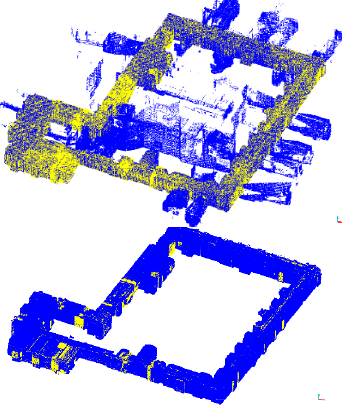
Figure 3. Pre-processing of two datasets, MMS (yellow) and SLS acquisitions (blue). Original point clouds (above) and segmented after removing inconsistencies